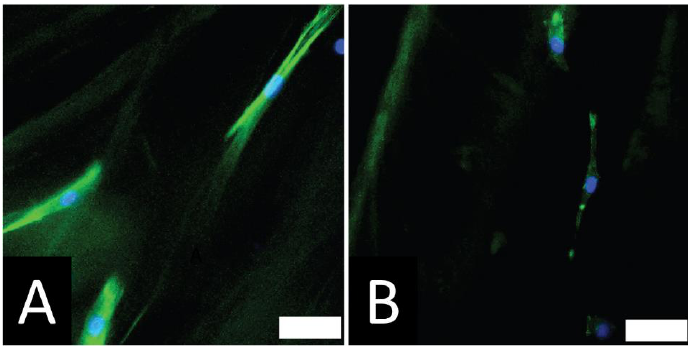
Figure 7. Cells respond to the topography of the PCL-based tissue scaffolds substrates and align on the substrates. ( A ) Schwann cells on non-electroactive scaffolds (scale bar represents 50 µm); ( B ) Schwann cells on electroactive scaffolds without electrical stimulation (scale bar represents 50